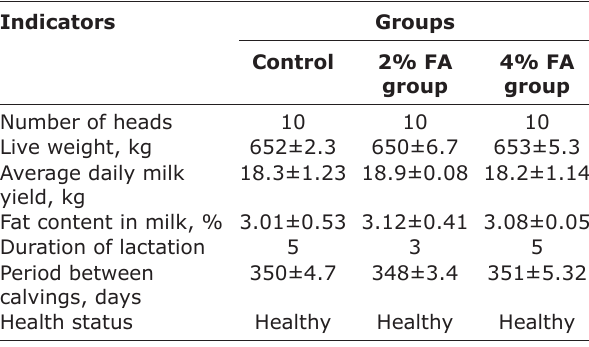
Table-1: Live weight and milk production of cows selected for the study (average values).